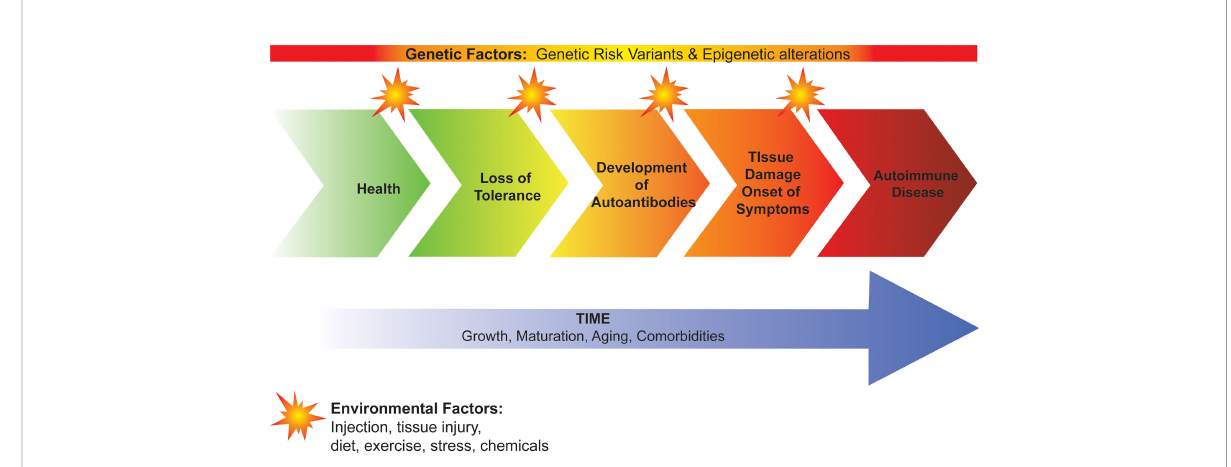
FIGURE 1 Development of autoimmunity and progression to autoimmune disease. Genetic factors predispose to loss of immune tolerance and the subsequent development of autoantibodies, tissue damage, and onset of clinical disease. Environmental factors act as triggers that initiate and promote disease progression. Growth, maturation, aging and comorbidities contribute to the rate of progression from loss of tolerance to autoimmune